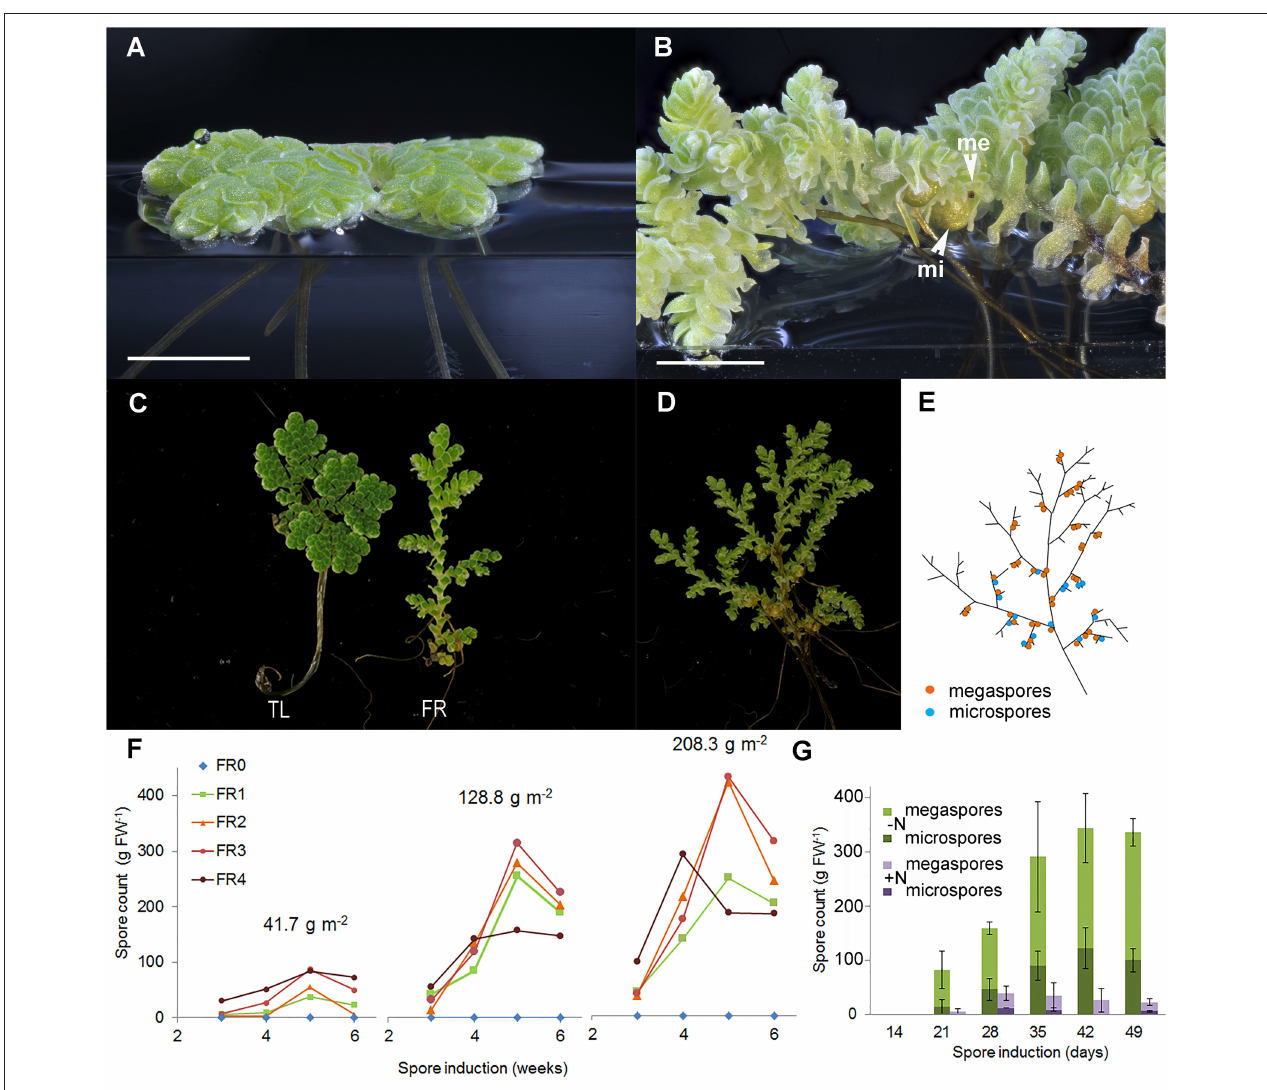
FIGURE 2 | Far-red (FR) light and nitrogen affect the reproductive phase transition in A. filiculoides . (A) Vegetatively growing ferns. (B) Ferns in the reproductive phase with micro (mi) and megaspores (me). (C) Growth habit under tube light (TL) and TL with FR light emitting diodes (FR). (D) A mature sporophyte and (E) its schematic representation: a root is formed at each branch point, and sporocarp pairs are found close by on the branch side of the branch point but not at all branch points. (F) Sporulation frequencies at increasing plant density (41.7, 128.8, and 208.3g m − 2 dry weight) and with increasing red to FR light ratios (FR0–FR4). The red to FR ratios were 19.13 (FR0), 1.16 (FR1), 0.63 (FR2), 0.50 (FR3), and 0.31 (FR4); to obtain the FR4 ratio, the TL intensity was halved. Each data point represents the average of three independent continuous growth replicates. (G) Induction of sporulation without nitrogen (–N) or with 2mM NH 4 NO 3 ( + N) in the medium, the data are averages from the three replicates with SD